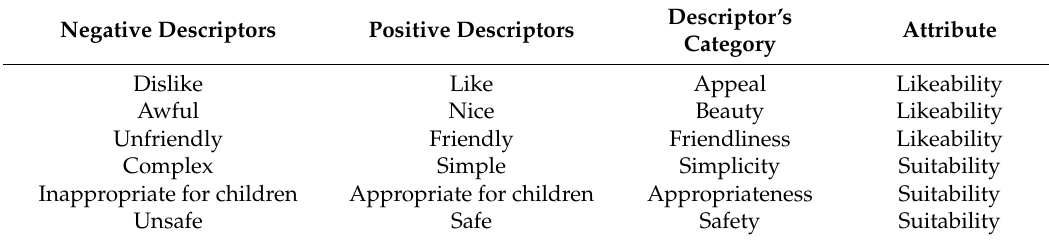
Table 1. The table presents the list of attributes used to evaluate the robot’s